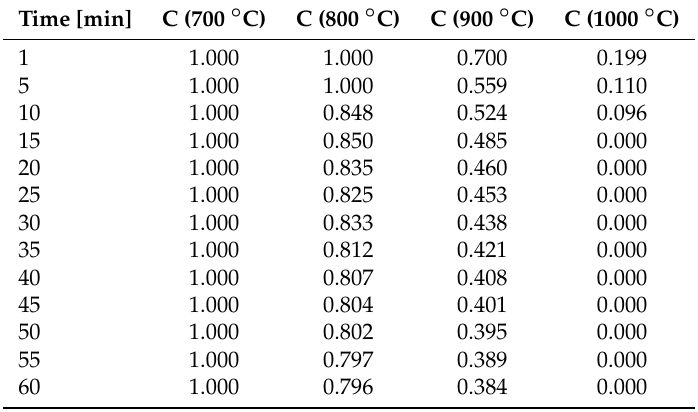
Table 1. Summary of the calculated α concentration as a function of